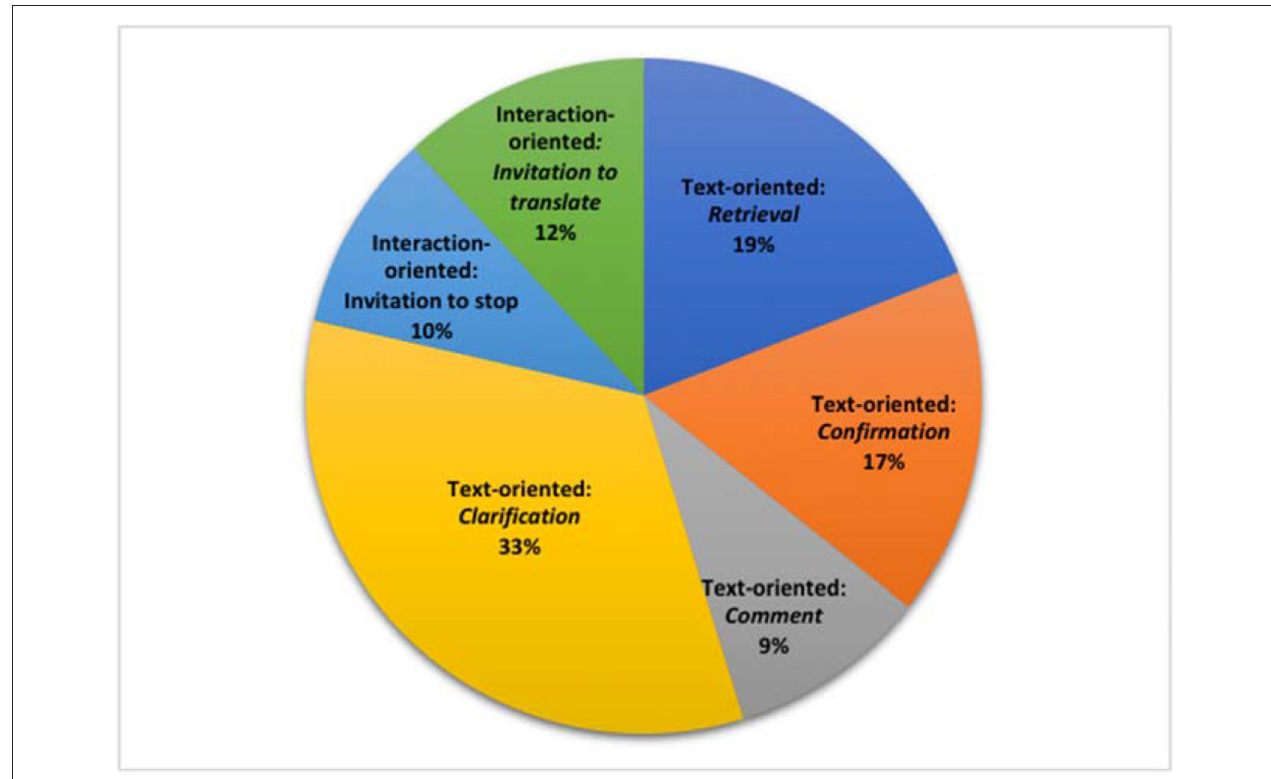
FIGURE 1 | Frequency and types of extra-textual